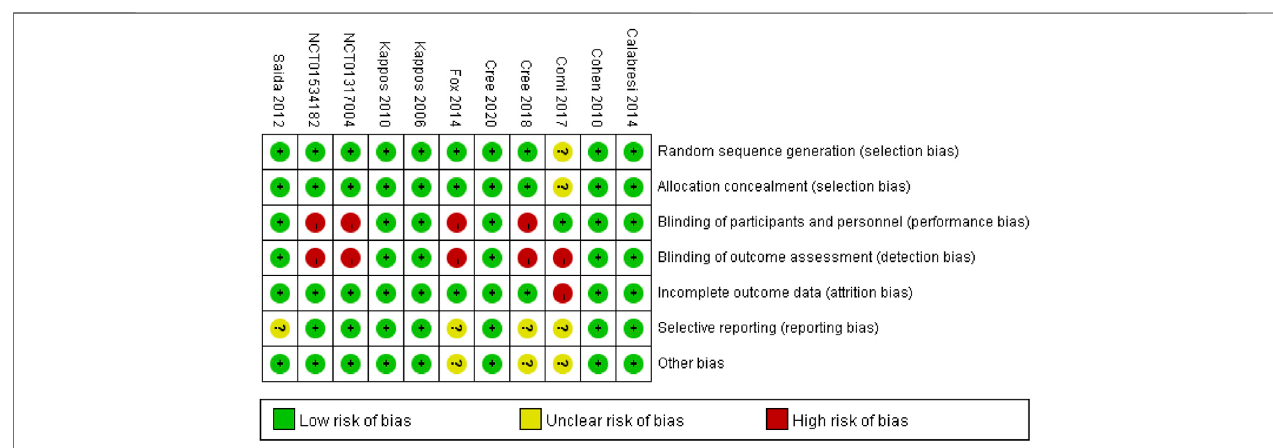
FIGURE 2 | Risk of bias: A summary table for each risk of bias item for each study.